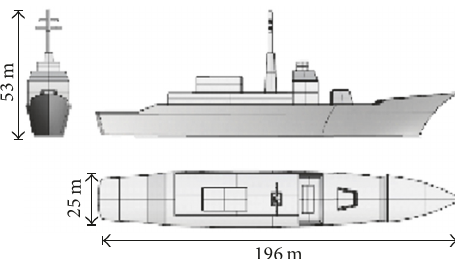
Figure 6: Illustration of dimensions of the ship.